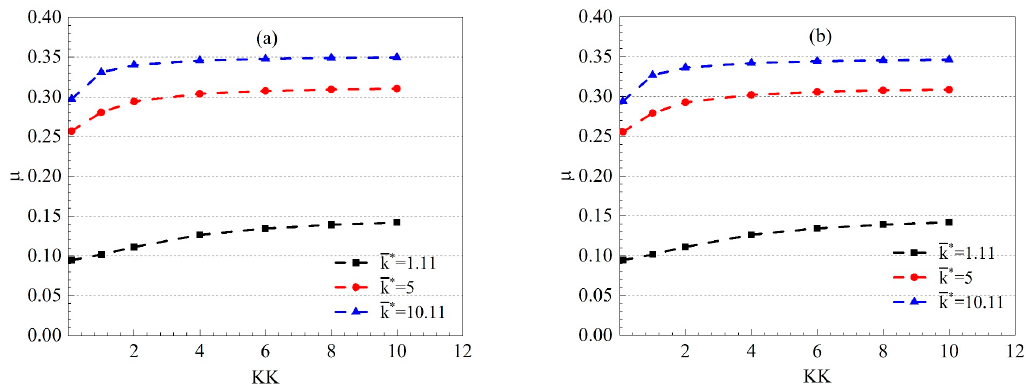
∗ ) and sti ff ness ratio factor (KK) * k ) and stiffness ratio factor